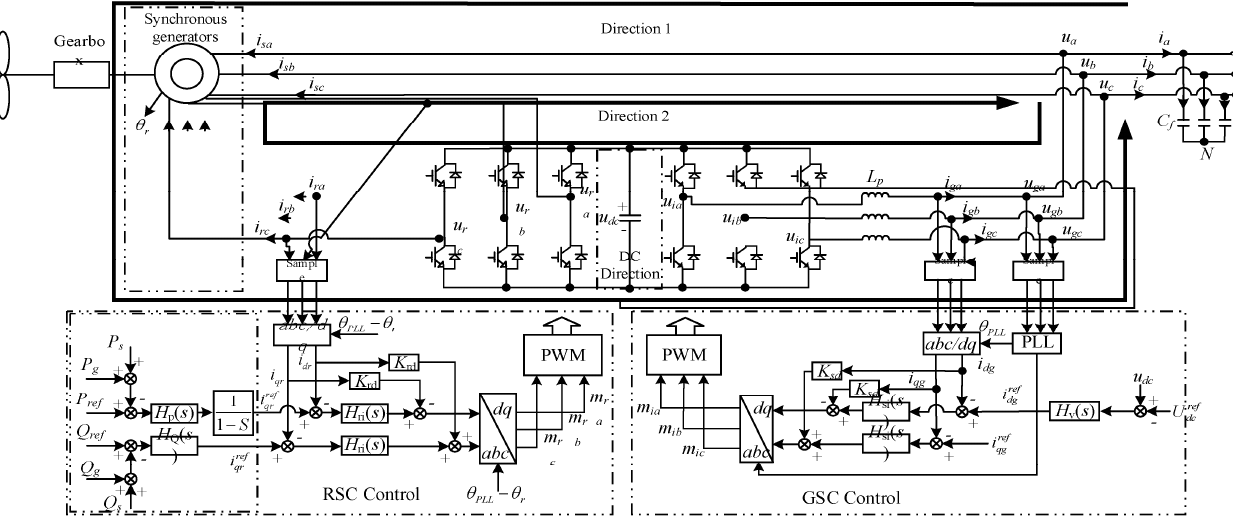
Figure 4. Con fi guration and control of DFIG system. Figure 4. Configuration and control of DFIG